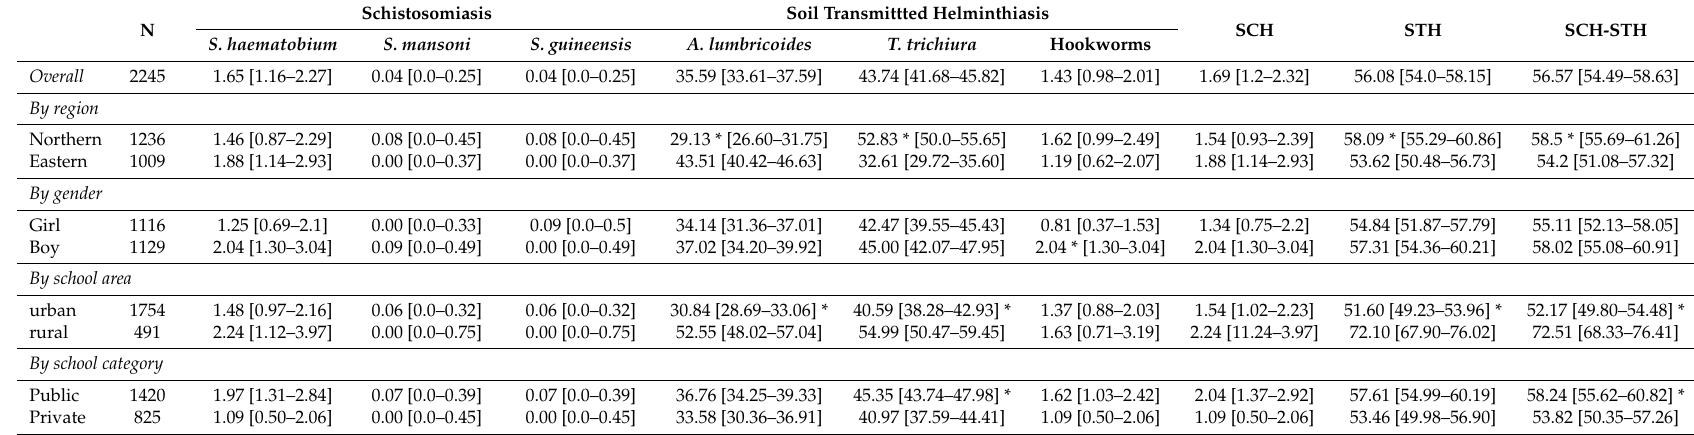
Table 1. Percentage of infected schoolchildren (prevalence) [95% confidence intervals], at overall level, at regional level, according to gender, school area, and school